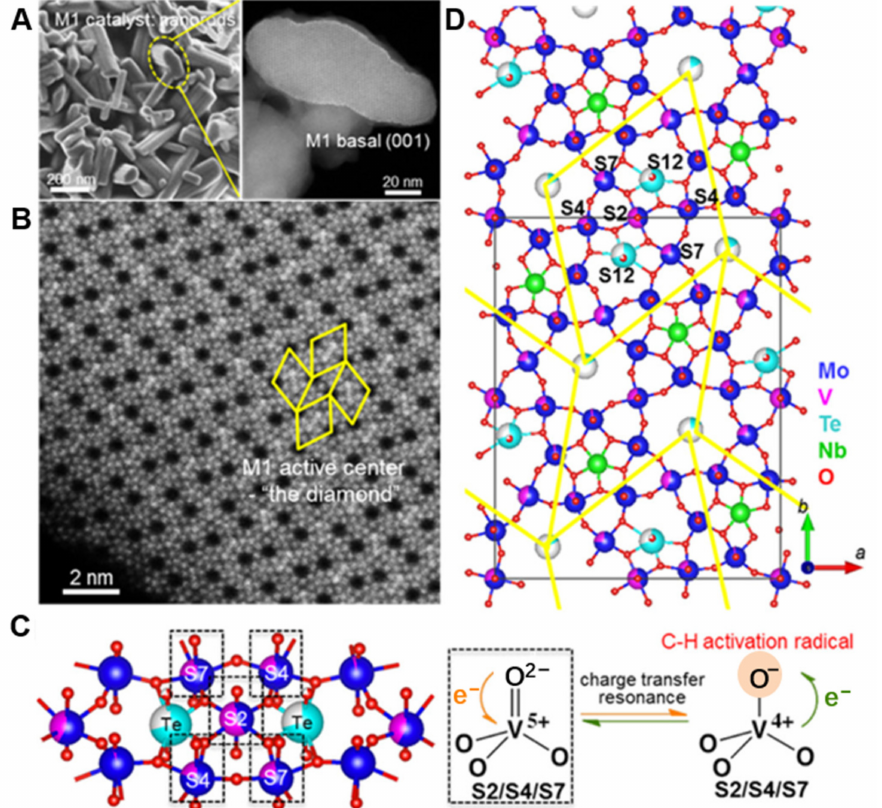
Figure 8. ( A ) SEM image of rod-like Te-M1 catalysts and STEM overview of its (001) basal plane. ( B ) High-resolution low-angle annular dark field STEM image of proposed active centers (S2–S4–S7 in the yellow-diamonds). ( C ) Atomic model of the Te-M1 phase (unit cell in black frame). ( D ) Scheme of the proposed V=O active site on Te-M1. Adapted from ref. [83], Copyright (2017), with permission from the American Chemical